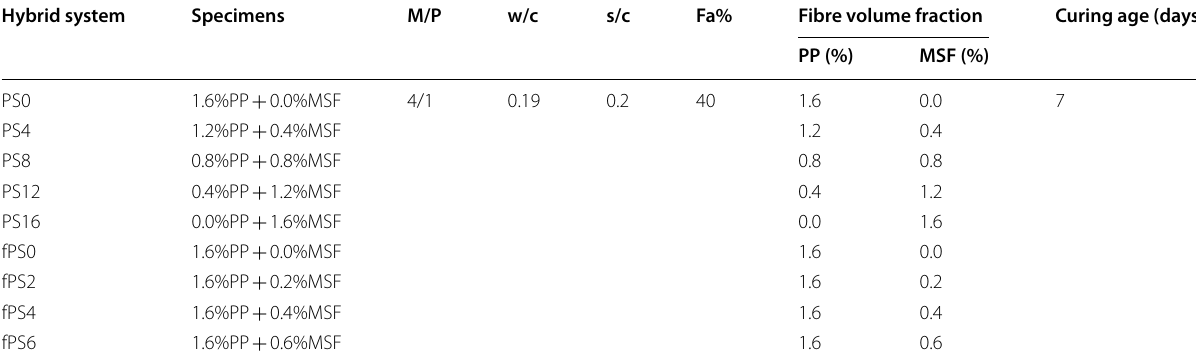
Table 3 Mix design of fibre-reinforced MPC mortar.